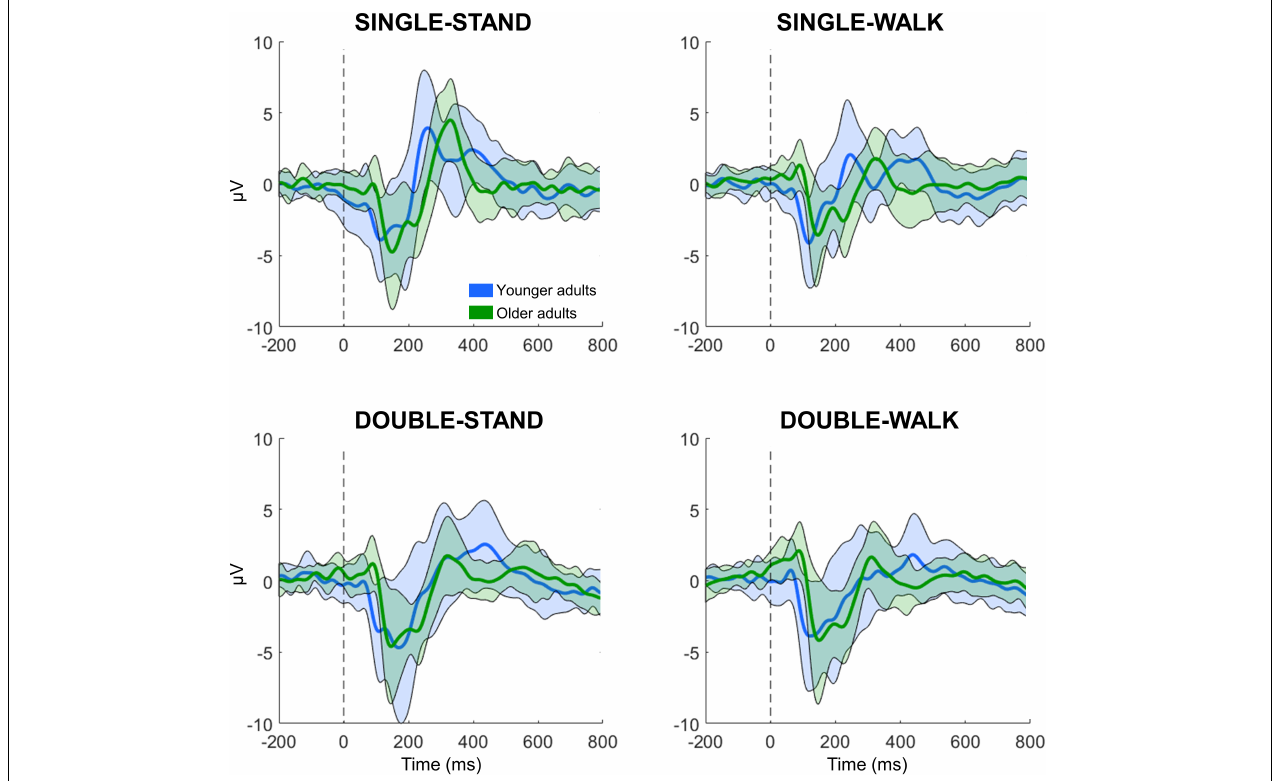
FIGURE 1 | Grand averaged EEG signals from channel Pz for the younger ( n = 21, blue ) and older adults ( n = 19, green ) while performing the response time task in four different conditions: single stimulus while standing (SINGLE-STAND), single stimulus while walking (SINGLE-WALK), double stimuli while standing (DOUBLE-STAND), double stimuli while walking (DOUBLE-WALK). The thick line represents the average, and the shaded area represents ± 1 standard deviation.